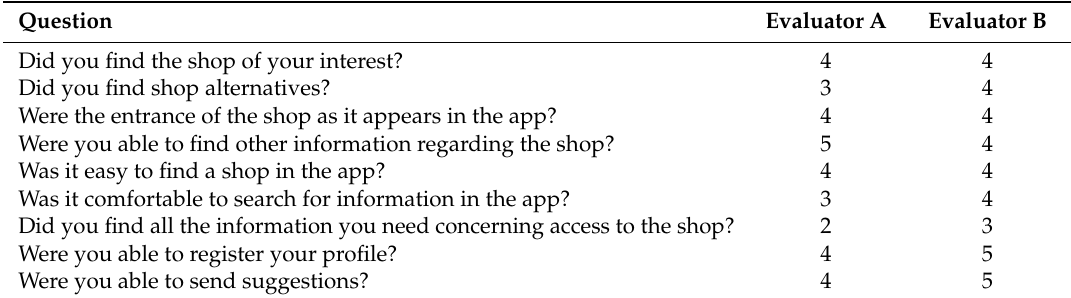
Table 2. Cognitive walkthrough evaluation of the app ACCEDE